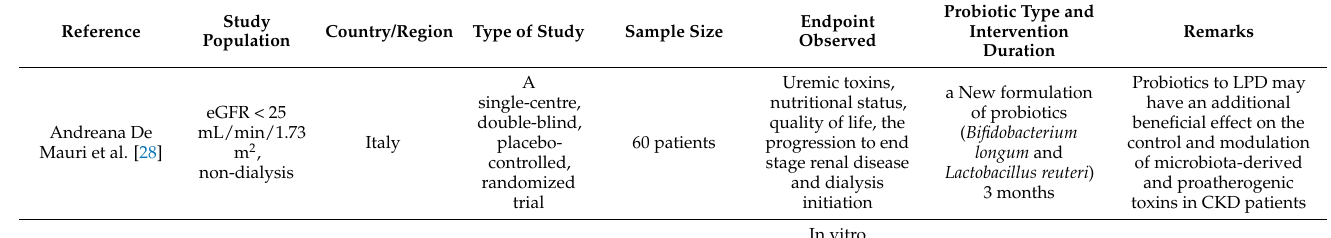
Table 1. Summary of clinical trials on probiotic treatment used in patients with advanced CKD stage